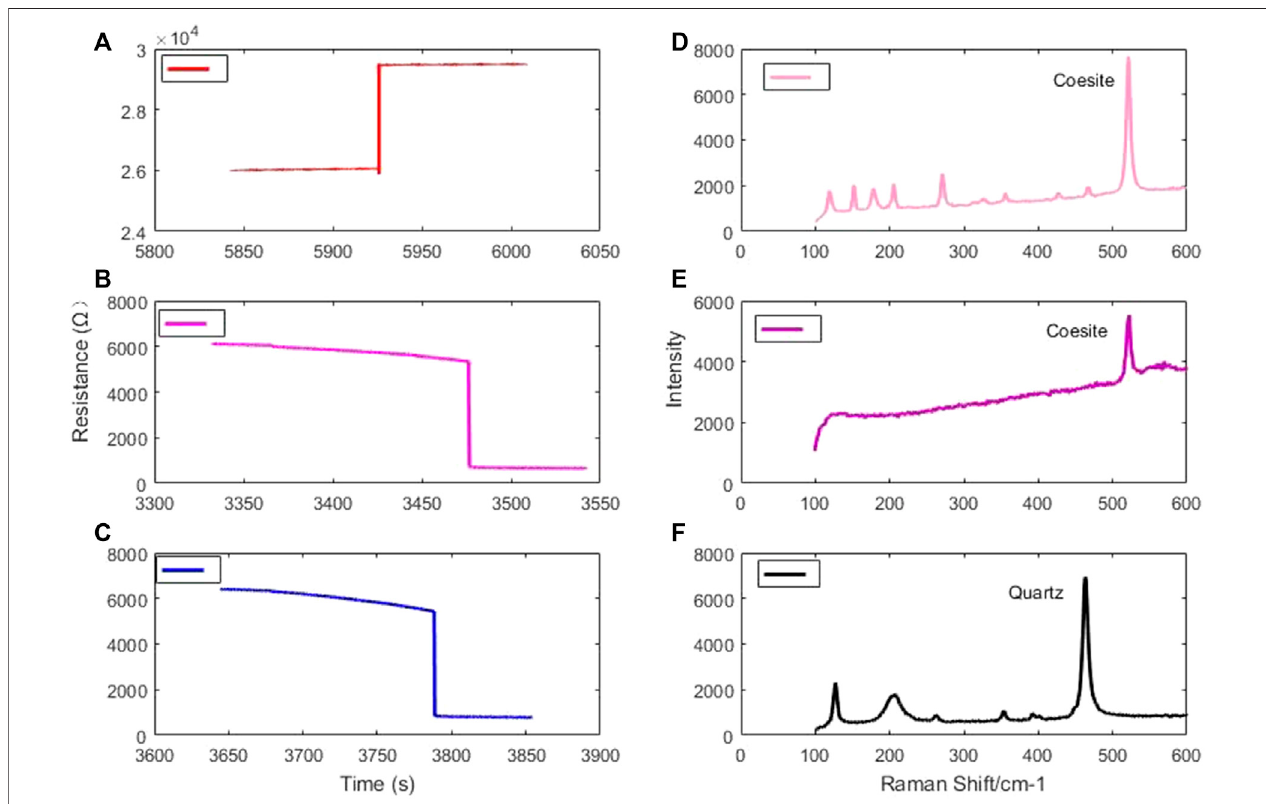
FIGURE2|(A) Timetrendofwaterresistance, (B) TimetrendofZnSresistance, (C) TimetrendofKClresistanceatanoilpressureof10 MPa, (D) Ramanspectrum of the experimental product of the phase transition of quartz at 1,000 ° C, (E) Raman spectrum of the experimental product of the phase transition of quartz at 1,500 ° C, and (F) Raman spectrum of quartz before the phase transition.